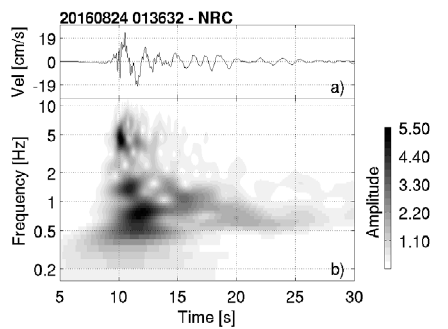
Figure 10 . Velocity time history (a) and power spectrum (b) of the E component at station